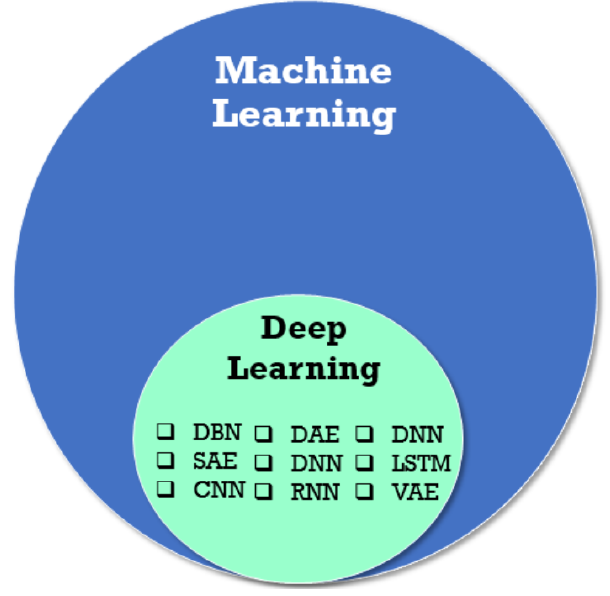
Figure 4. Deep Learning